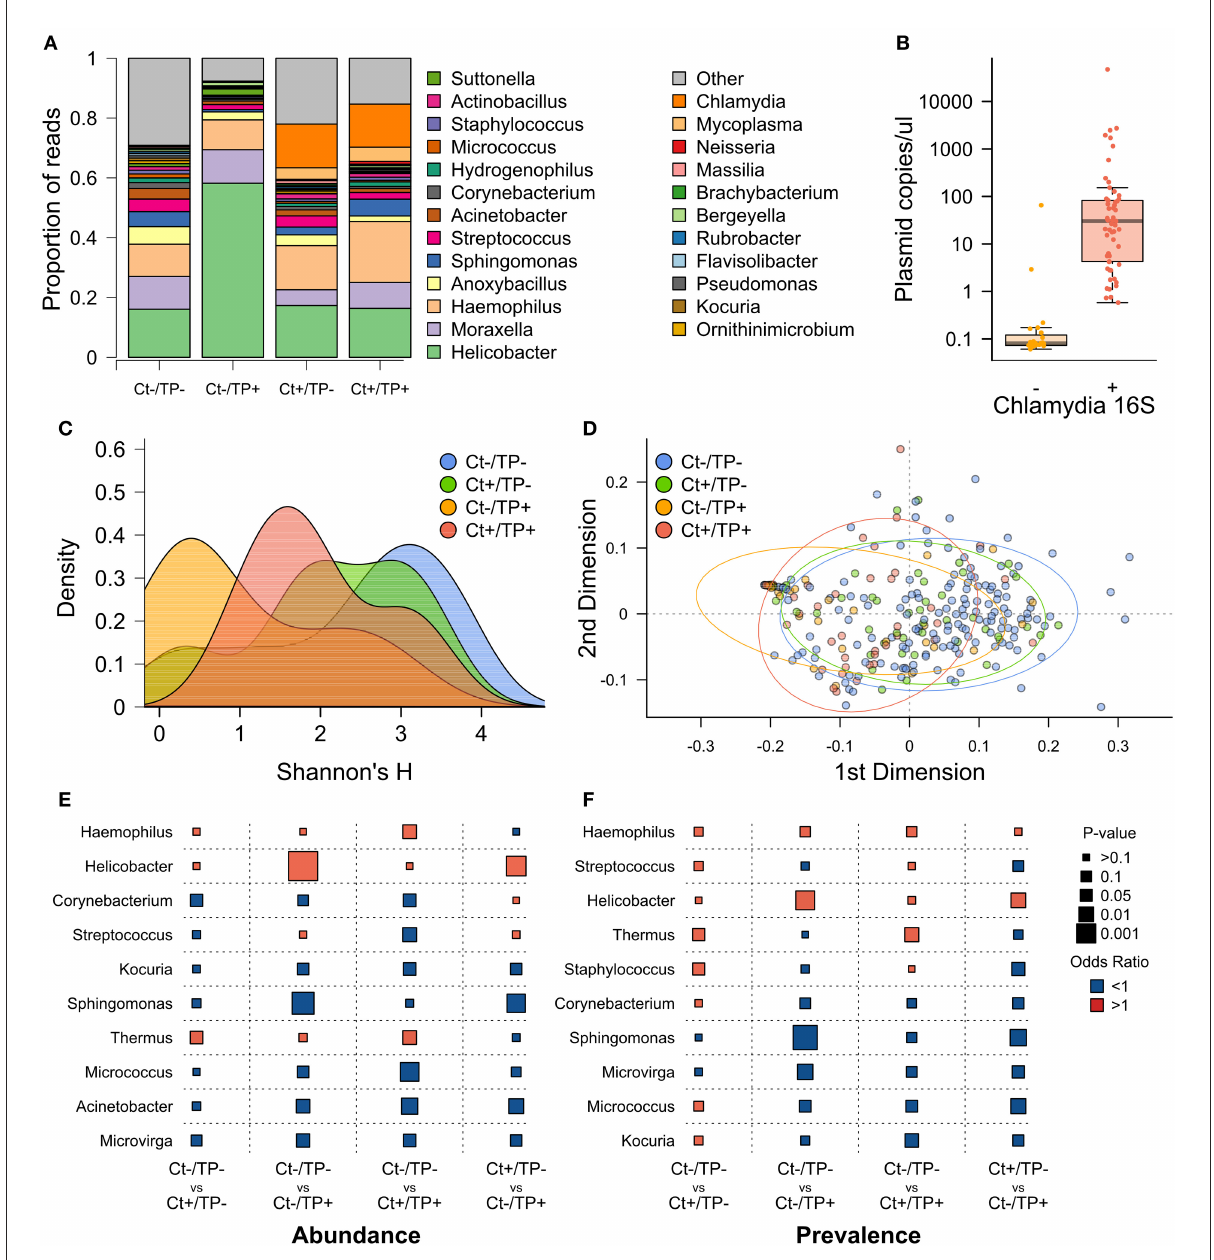
FIGURE1 Pre-MDA ocular microbiome by Ct and TP status. (A) Genera with ≥ 1% relative abundance, all genera below < 1% are grouped as “Other.” (B) Ct plasmid load, quantified by PCR, in children who had detectable Chlamydia reads by 16S rRNA PCR ( + ) or not (–). (C) Alpha diversity, measured by Shannon’s H, by group. (D) PCA of beta diversity, measured by weighted uniFrac distance. (E) Logistic regression comparing genera abundance between indicated clinical groups, odds ratio (color of points; red > 1, blue < 1) and p -value (size of points). (F) Logistic regression comparing genera prevalence (read count > 0) between indicated clinical